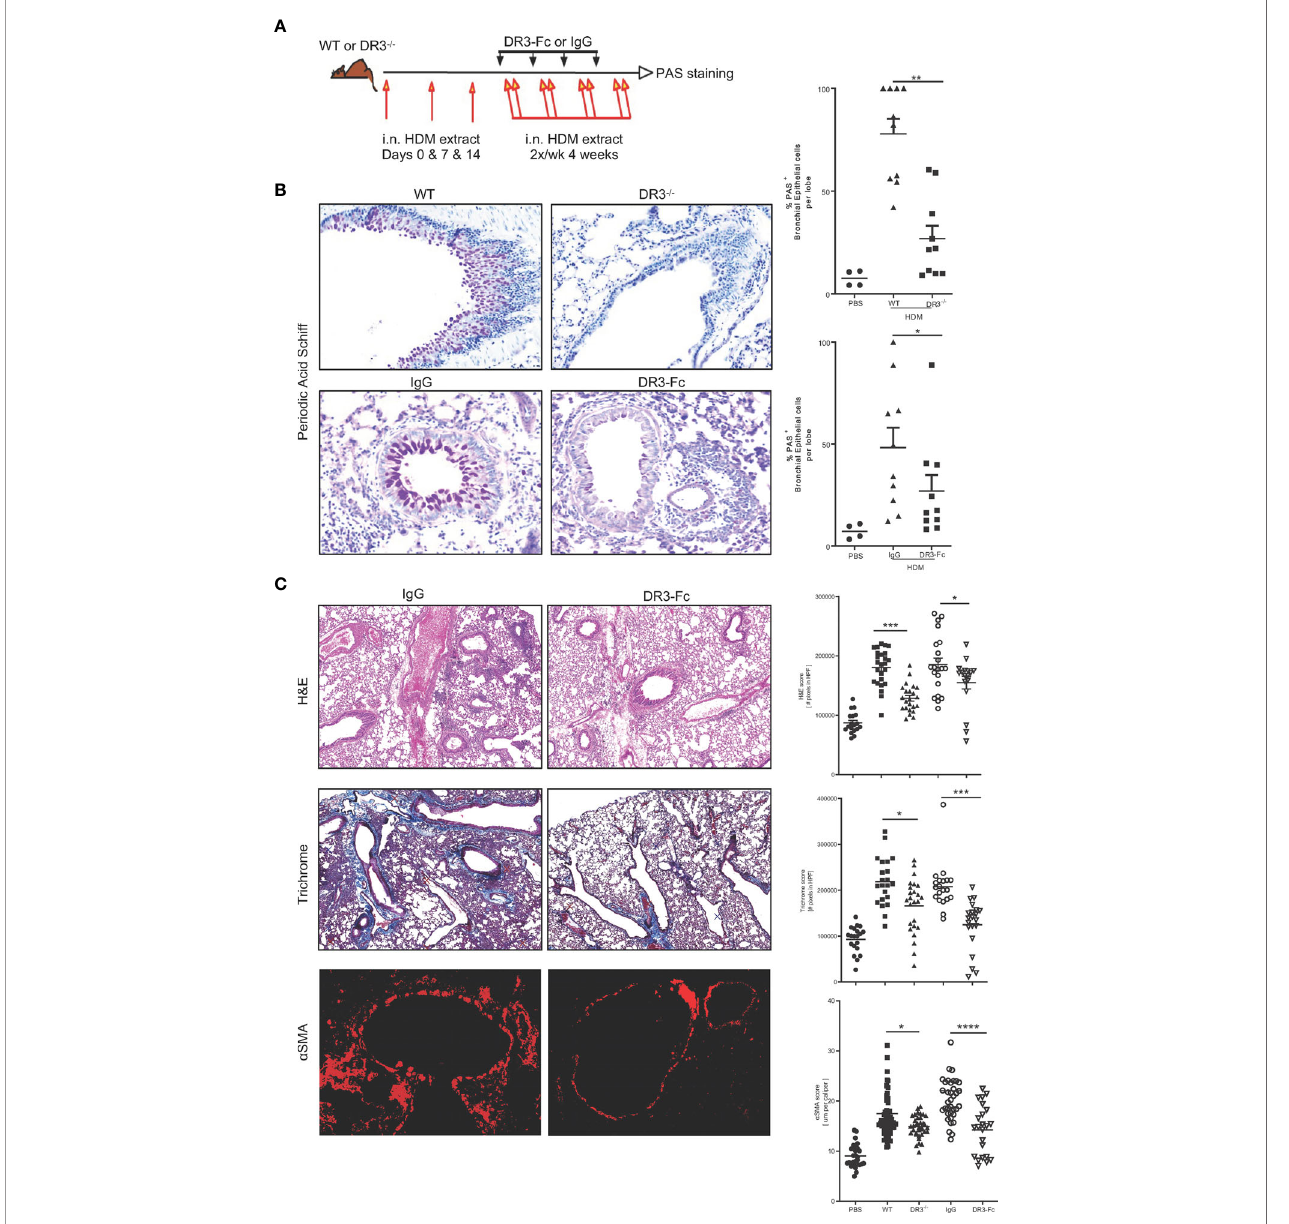
FIGURE 2 | Interrupting TL1A/DR3 signaling decreases mucus production in allergen-induced asthma. (A) Schematic representation of protocol used. Brie fl y, WT littermates and DR3-de fi cient mice on the C57BL/6 x 129 background were sensitized i.n. on day 0, 7, and 14 with 200 and 100 m g house dust mite extract protein in PBS, followed by chronic i.n. challenges of 50 m g of HDM protein administered twice a week for the following four weeks. Analyses were performed 24 hours after the last challenge. For neutralization of TL1A-DR3 interactions, mouse DR3-Fc or isotype control IgG were administered i.p. to WT C57BL/6 mice after the initial sensitization period starting at day 14 and were given every three days until the end of the experiment (100 m g/injection/mouse). (B) PAS stain of mucus produced in the lungs and quanti fi ed using Image Pro Premier. (C) In fl ammation assessed by H&E stain (top panels), collagen deposition assessed by trichrome stain (middle panels), and smooth muscle hypertrophy assessed by a SMA immuno fl uorescence stain (red) (bottom panels) on lung biopsies of WT C57BL/6 mice after treatment with either IgG or DR3-Fc. Quanti fi cations for each parameter, completed using Image Pro Premier, are shown to the right, including untreated WT C57BL/6 and DR3 -/- mice (images not shown). All results representative of three experiments with fi ve mice per group. *p < 0.05, ** < 0.005, ***p < 0.0005, ****p <